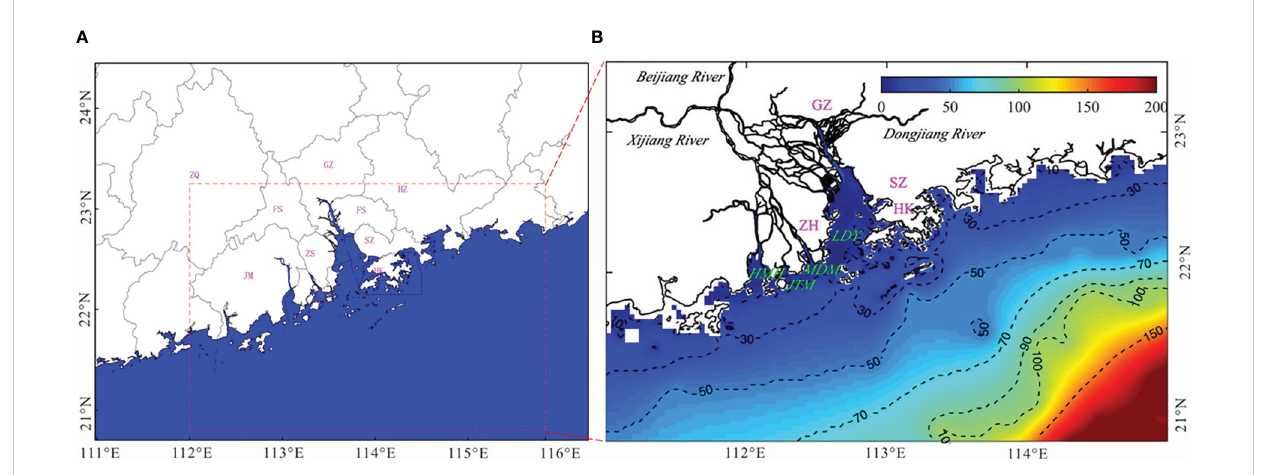
FIGURE 1 (A) Cites of Guangdong – Hong Kong – Marco Greater Bay Area, including Zhao-Qing (ZQ), Guang-Zhou (GZ), Hui-Zhou (HZ), Fo-Shan (FS), Dong- Guan (DG), Jiang-Men (JM), Zhong-Shan (ZS), Shen-Zhen (SZ), Zhu-Hai (ZH), Macau (MC), and Hong Kong (HK). (B) The tributaries of Pearl River, the Pearl River Estuary (PRE) and adjacent seas. Abbreviations are sub estuaries, including Ling-Ding-Yang (LDY), Mo-Dao-Men (MDM), Huang-Mao-Hai (HMH), and Ji-Ti-Men